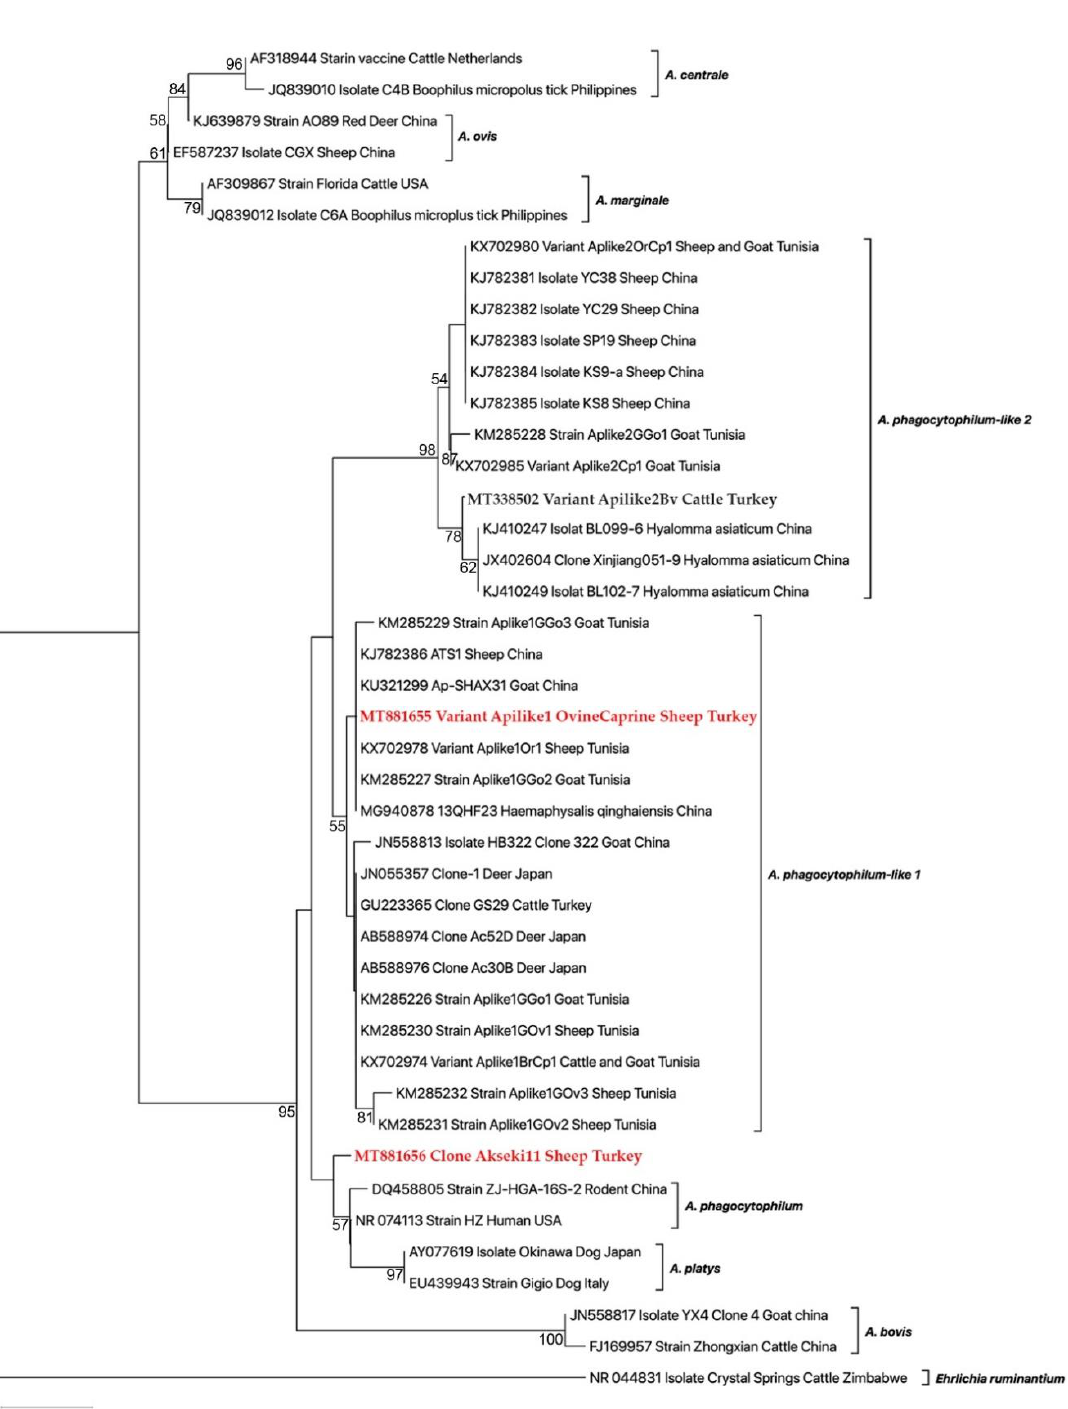
Figure 2. Maximum likelihood phylogenetic tree was inferred with partial sequences (598–599 bp) of the 16S rRNA gene of Anaplasma sp. related to A. phagocytophilum isolated from sheep in Turkey (highlighted in red) with other Anaplasma spp. retrieved from GenBank. Numbers at the nodes refer percentage occurrence in 1000 the bootstrap replication. The new sequences of A. phagocytophilum -like 1 and A. phagocytophilum from this study were highlighted in red. Ehrlichia ruminantium was used as an outgroup.